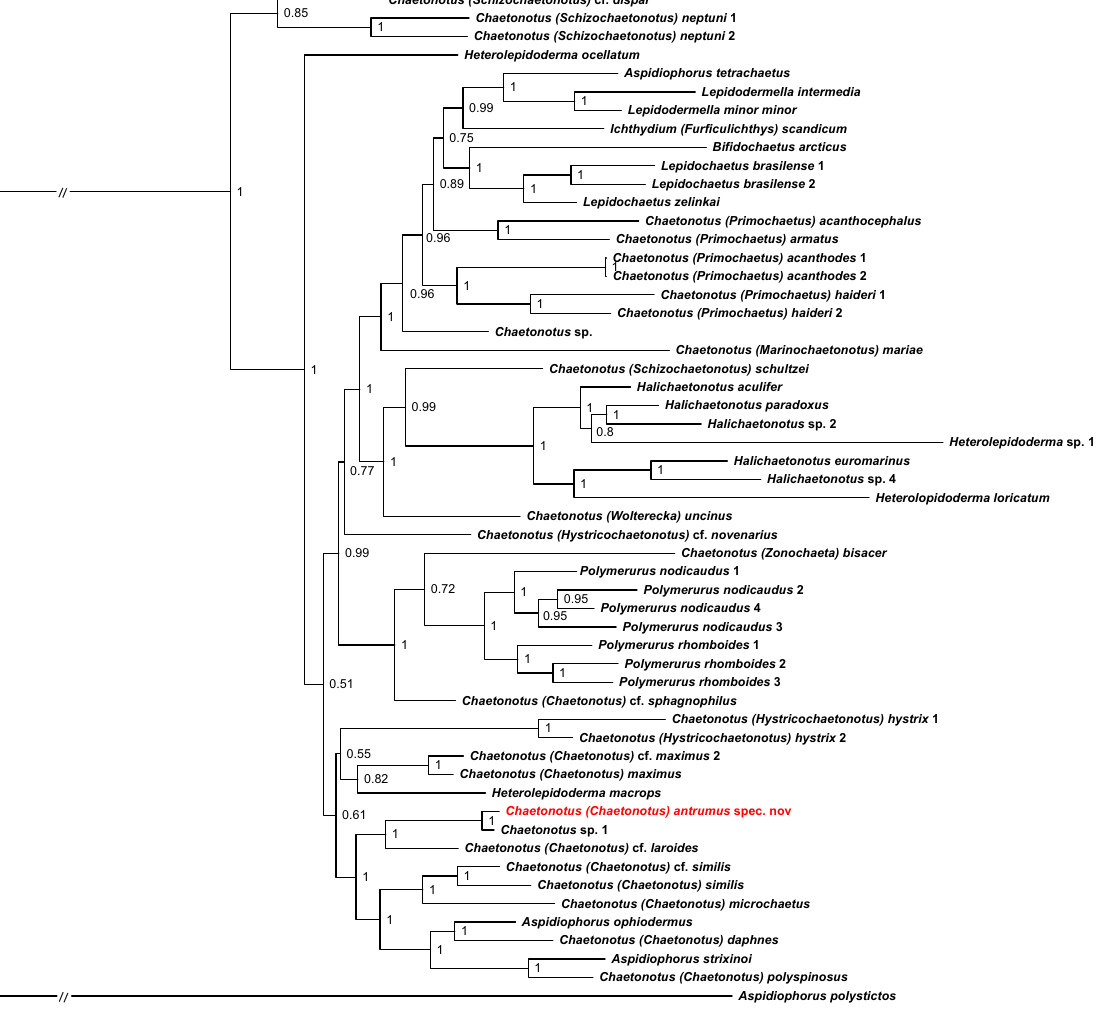
Fig. 11. Phylogenetic relationships of Chaetonotidae inferred from the Bayesian analysis of 18S rRNA, 28S rRNA and COI sequence data (for details on the species names see Table 3).